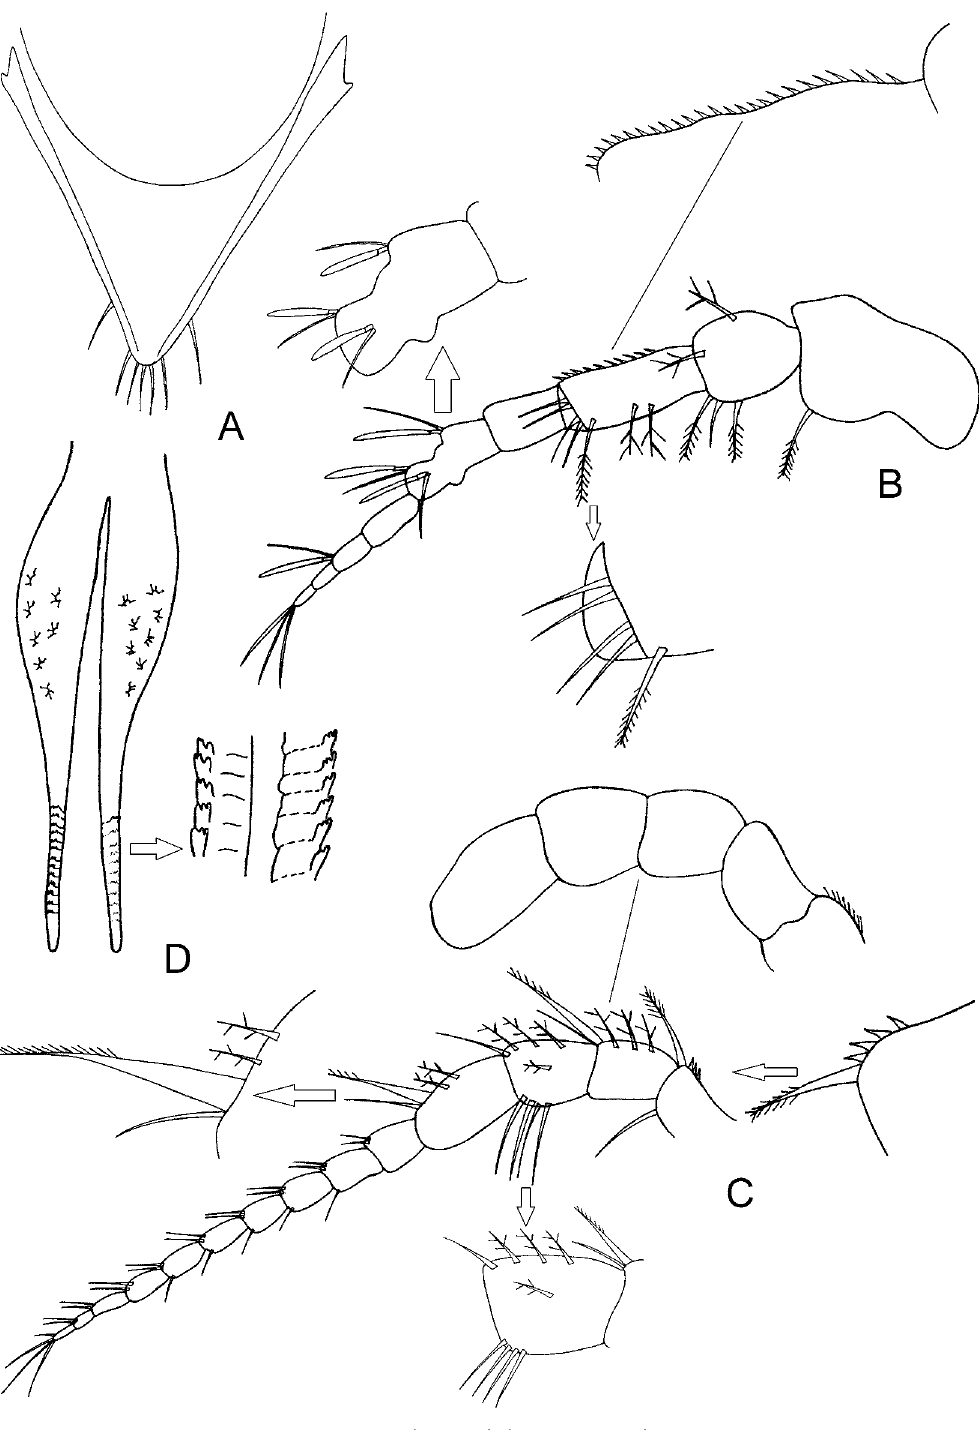
Figure 3. Sphaeromopsis jayaraji sp. nov., holotype male (2.9 mm) (PUMB 35104). A , ventral view of pleotelson; B , antennula; C , antenna; D ,